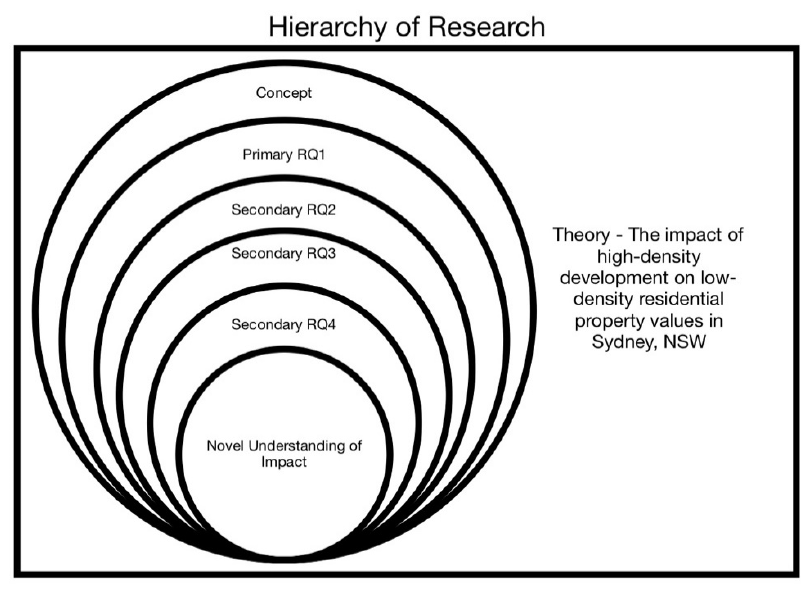
Figure 2. Hierarchy of Research.